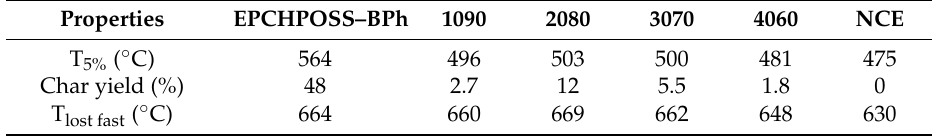
Table 1. Thermal stability of EPCHPOSS–BPh, 1090, 2080, 3070, 4060, and NCE